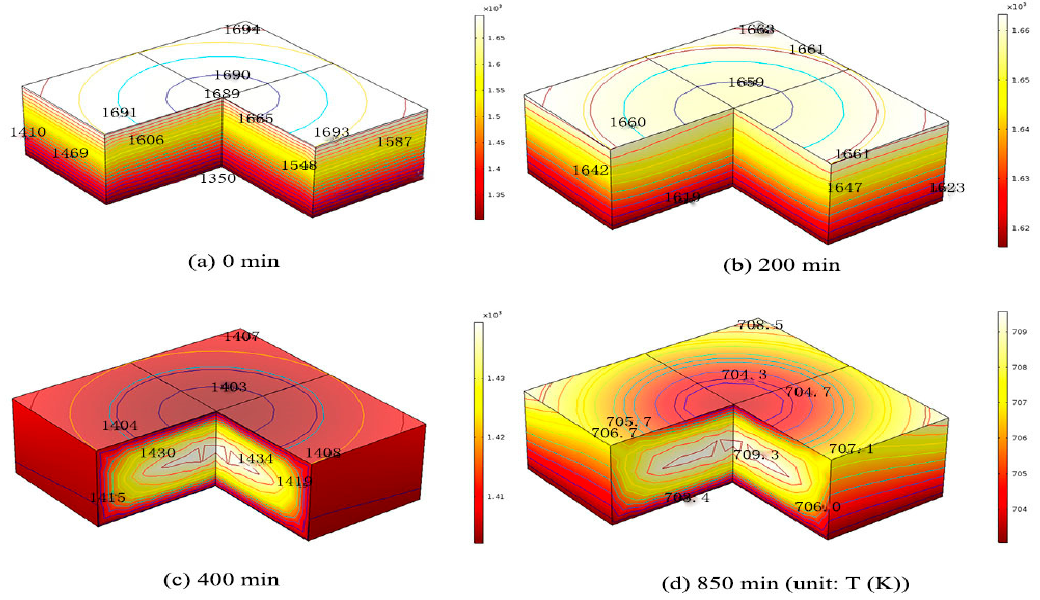
Figure 2. Temperature distribution of 0.84m × 0.84 m × 0.3 m silicon ingot at ( a ) beginning (0 min), ( b ) 200 min, ( c ) 400 min, and ( d ) end of the original cooling process (850 min).